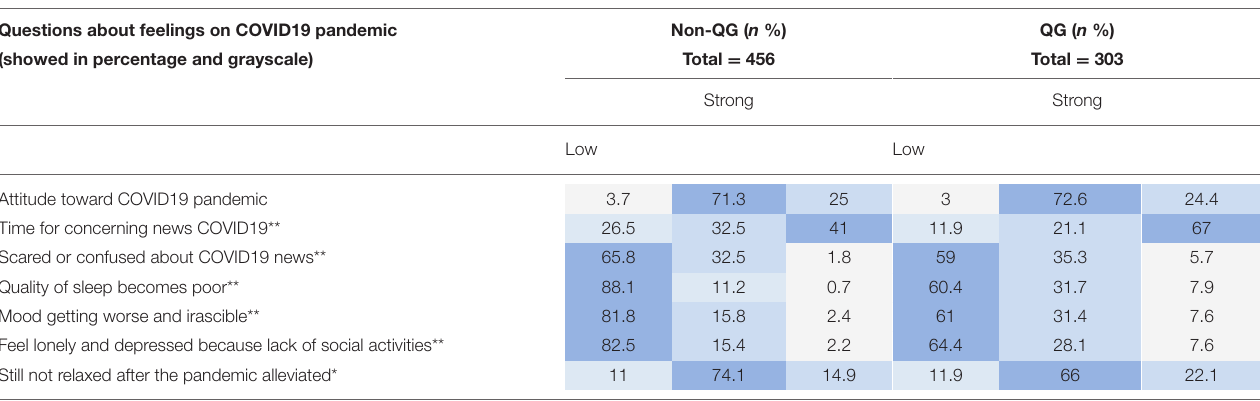
TABLE 3 | Summary of the responses on the emotional and somatic